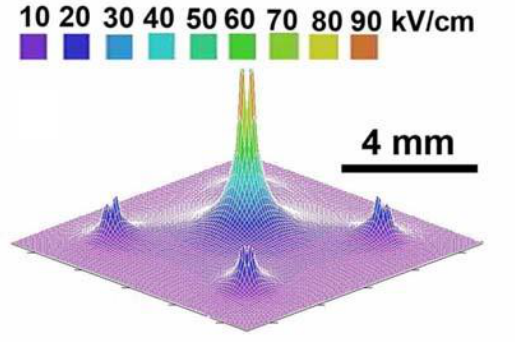
Figure 3. Needle array electric field pattern (reprint with permission from Elsevier